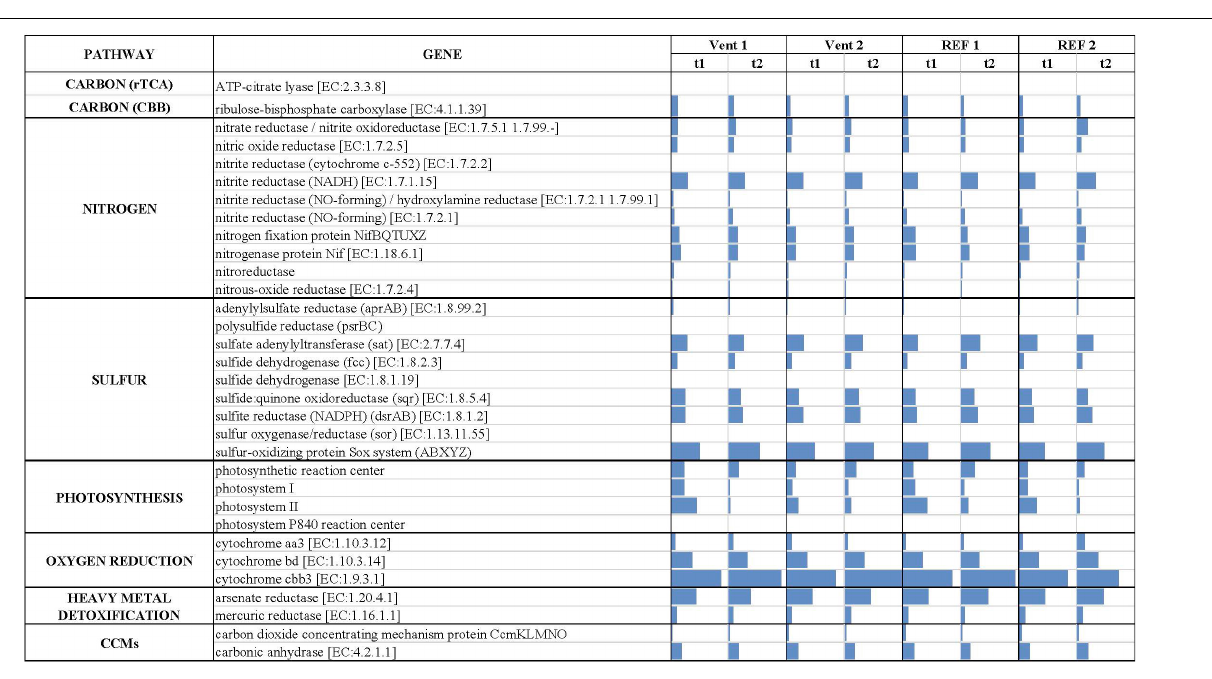
The simultaneous inputs of H 2 S and CO 2 from hydrothermal the assemblage of a metabolically diverse community,